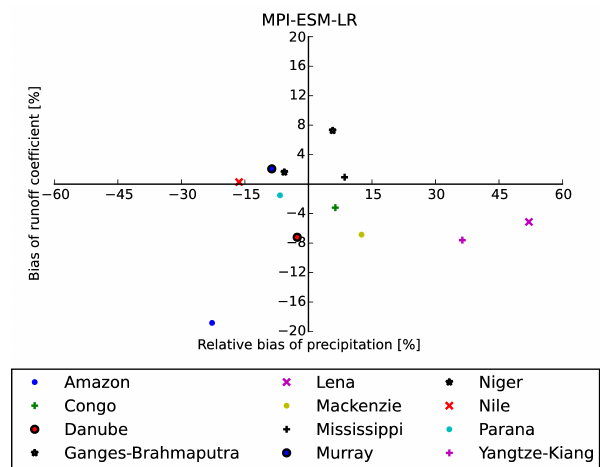
Figure 19. Biases in runoff coefficient (runoff/precipitation) and precipitation for major catchments of the globe. The MPI-ESM- LR historical simulation is used as an example. Even though posi- tive and negative precipitation biases exist for MPI-ESM-LR in the various catchment areas, the bias in the runoff coefficient is usu- ally negative. This implies that the fraction of evapotranspiration generally tends to be overestimated by the model independently of whether precipitation has a positive or negative bias. Produced with